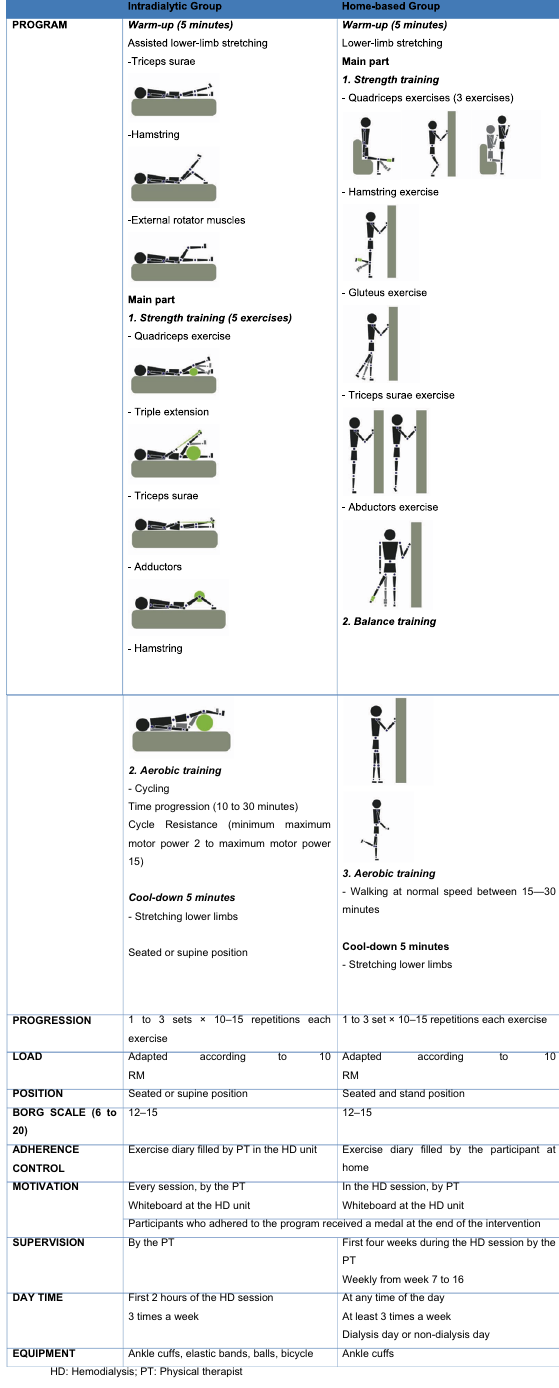
Figure 2. The exercise intervention completed by both the intradialytic and home-based trial groups. HD: Hemodialysis; PT: Physical